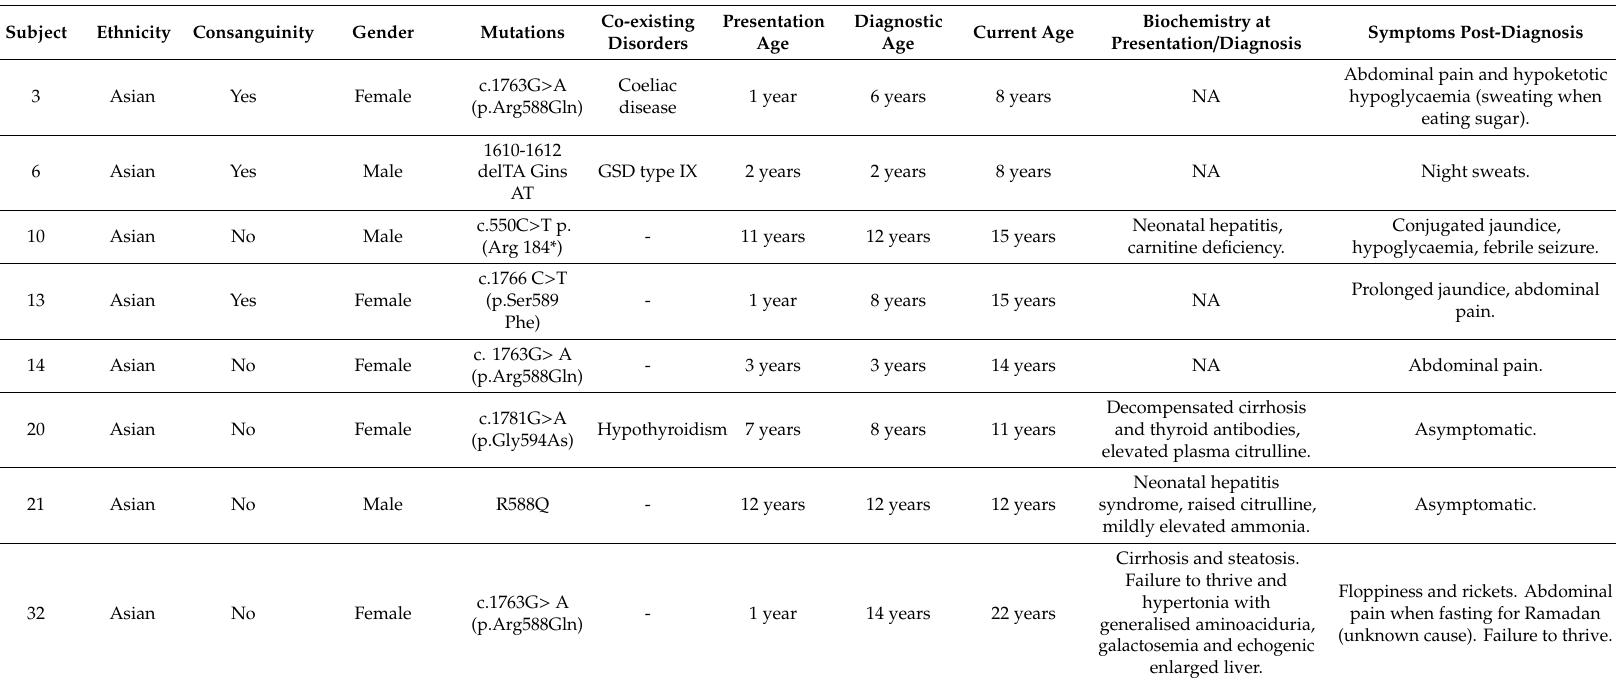
Table 3. Demographics, genetic results and symptoms on presentation for FTTDCD